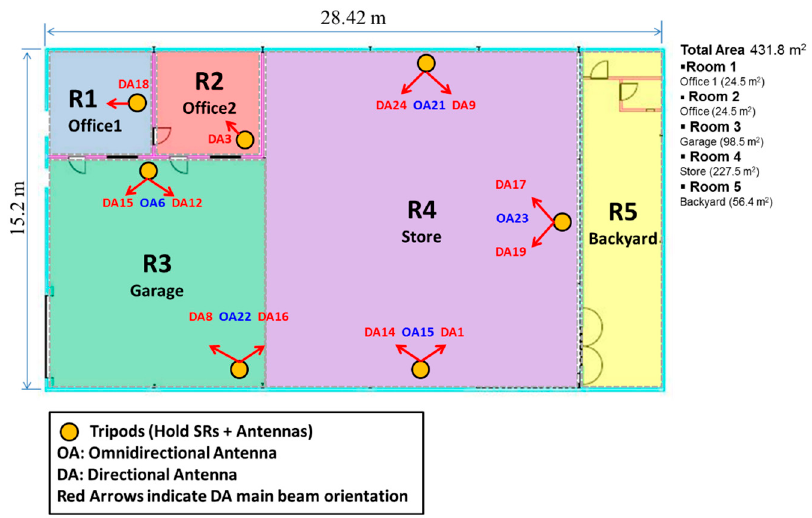
Figure 9. Experimental site and the sensor readers (SRs) deployed. Red arrows indicate the orientation of directional antennas.